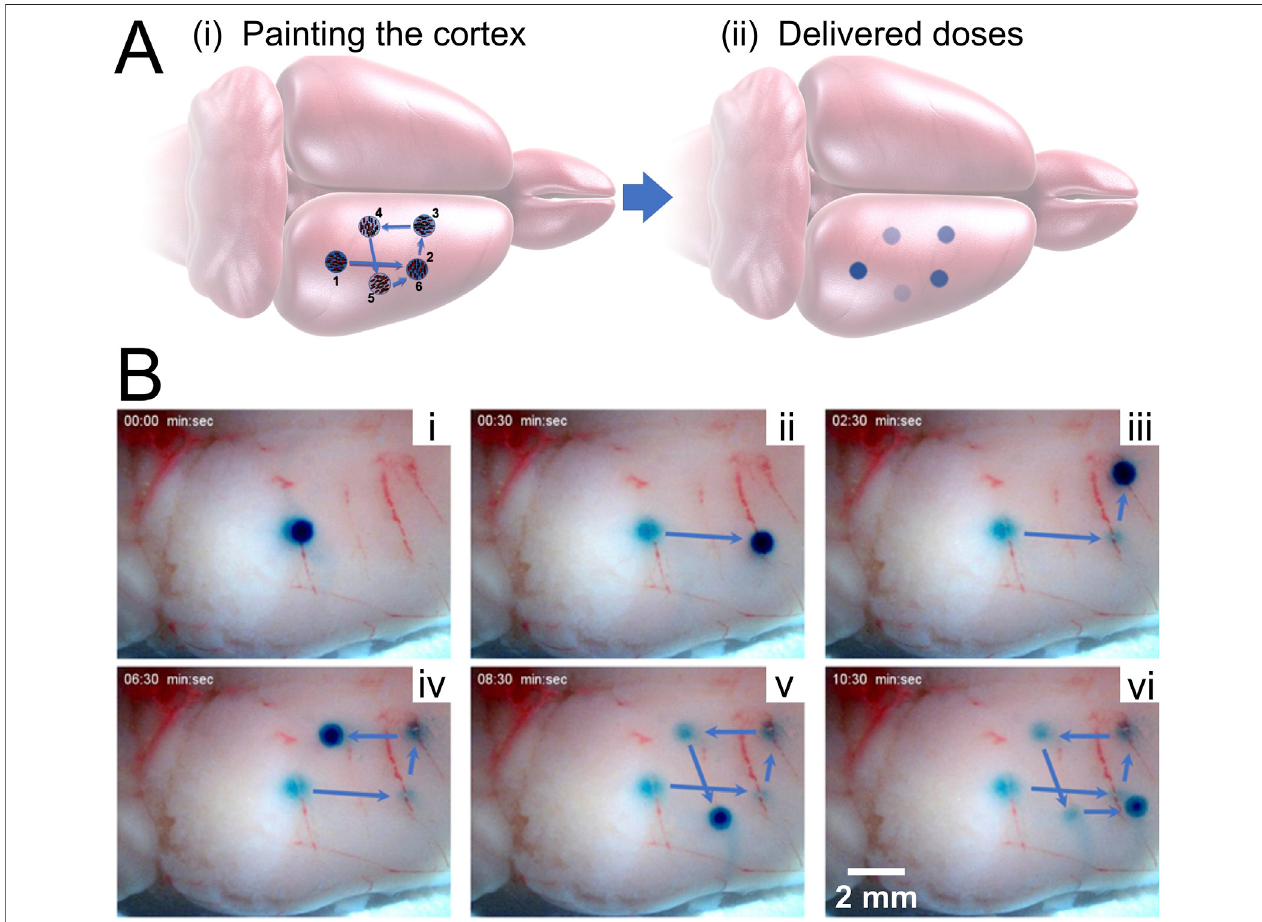
FIGURE7 | Painting the cortex. (A) Schematic showing the process of painting the ratcortex, showing target regions 1 – 5, with redosing (target 6) occurring at the same location as target region 2. [(A), ii] depicts the expected decrease in dose intensity as the dose experiment proceeds. (B) Experimental results showing painting a ratcortex exvivo . [(B),i ]through [(B),v] demonstratethe fi rst fi venovelpaintingdeliveries,while [(B),vi] demonstratesredosing.Onlytherightcortexisshown,withthe MANiAC fi rst movingintheanteriordirection [(B),i – ii] , followedbytranslation inthemedialdirection [(B),iii] followedbymotionintheposterior [(B), iv] lateral, [(B),v] , and fi nally anterior direction again. The entire process takes ∼ 10 min. Video included in Supplementary Information .